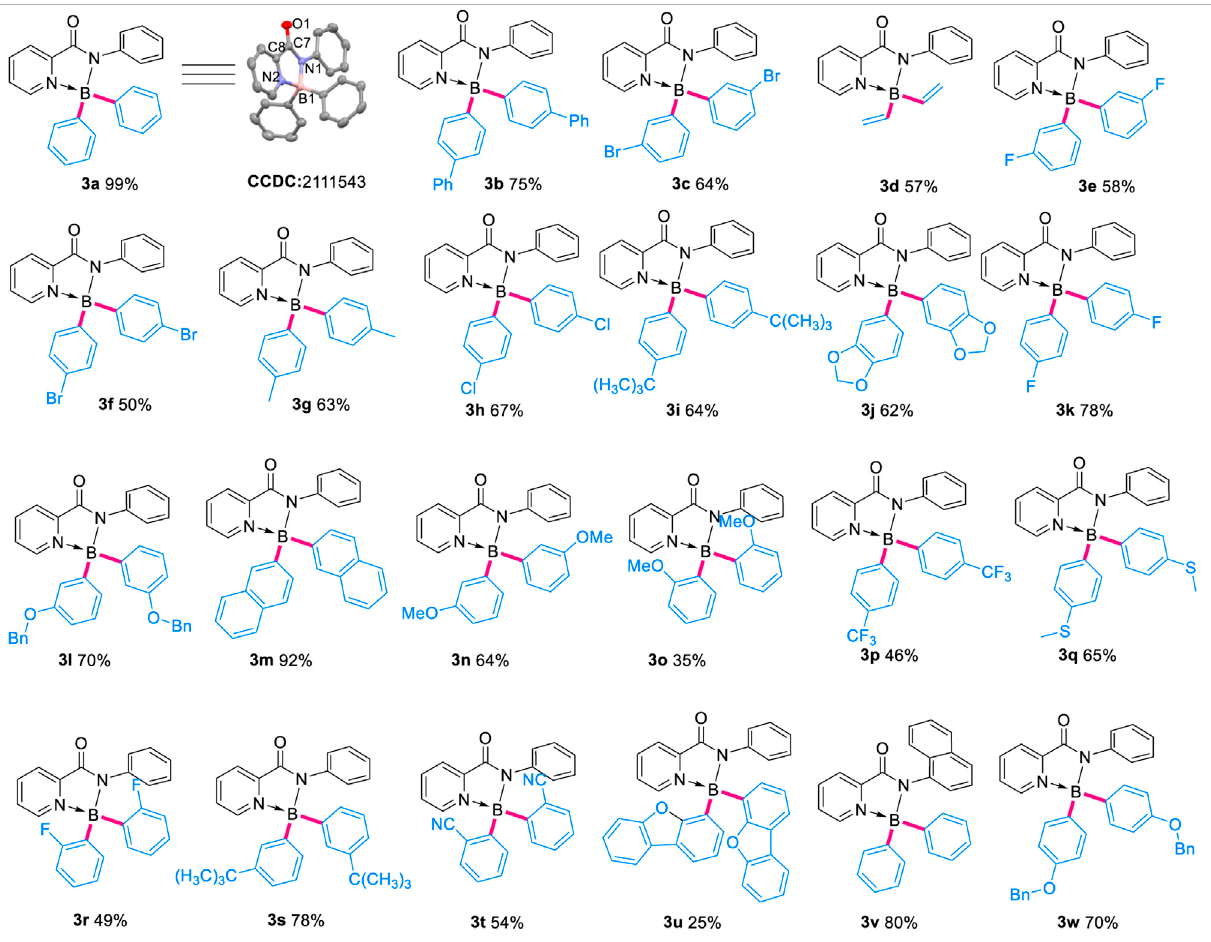
TABLE 2 | Optimization of reaction conditions a .